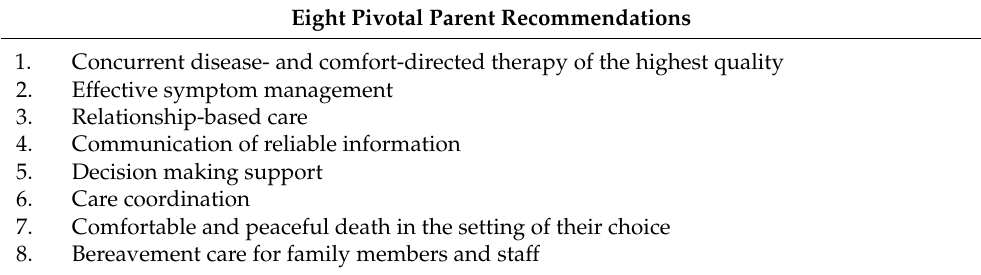
Table 1. Bereaved parents’ priorities for care of children with a poor prognosis. Eight Pivotal Parent